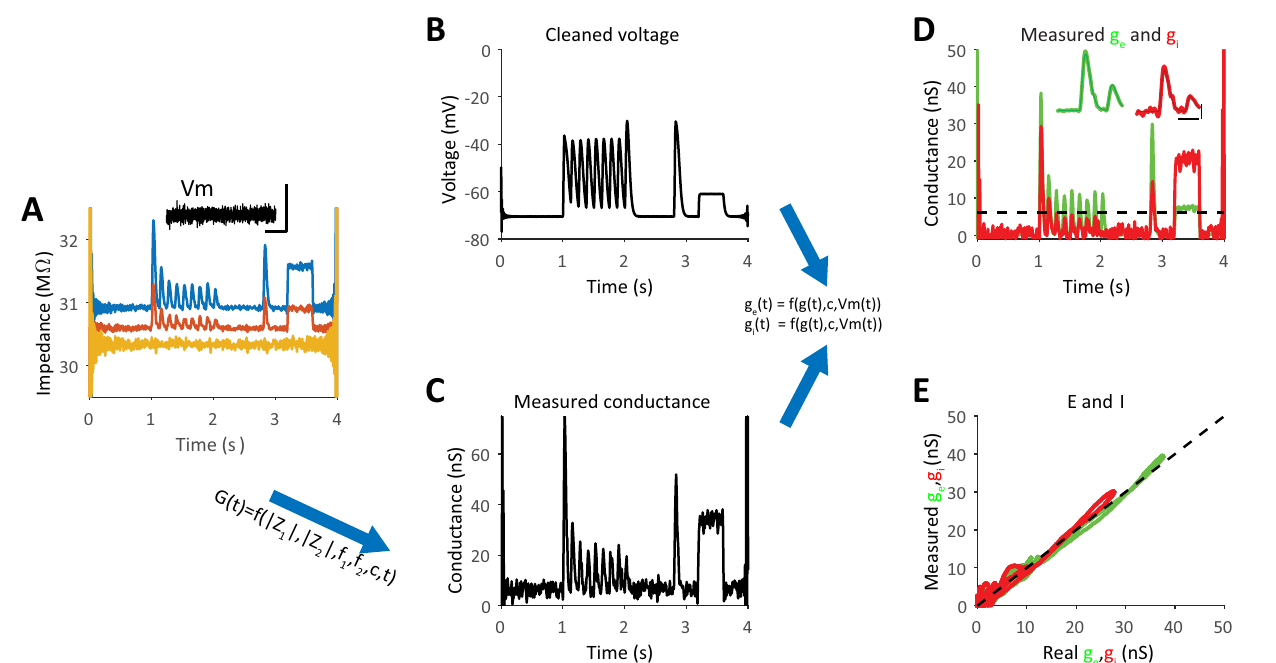
Fig 7. Measurements of g e and g i are accurate in the presence of realistic recorded noise. A. Absolute impedance curves for each frequency depicted together with the measured electrode resistance when real noise recorded from an in-vitro step was added to the simulated voltage before the measurement. The inset shows a voltage trace in absence of sinusoidal injection (scale bars: 0.5s, 0.5mV). All other parameters of the inputs are identical to those shown in Figs 3 and 4. B-E. Analysis of the voltage response of the point neuron as processed in the same way as shown in Figs 2, 3 and 6. Refer to Fig 3B for ground- truth g e and g i